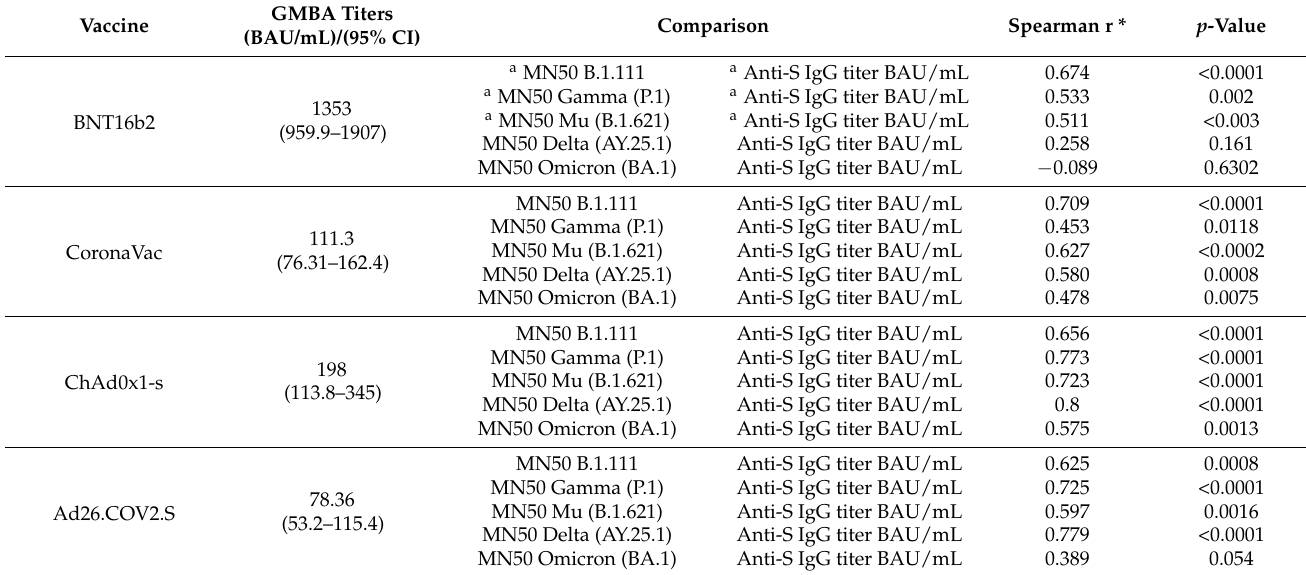
Table 1. Comparison of neutralizing and binding Anti-S IgG antibody